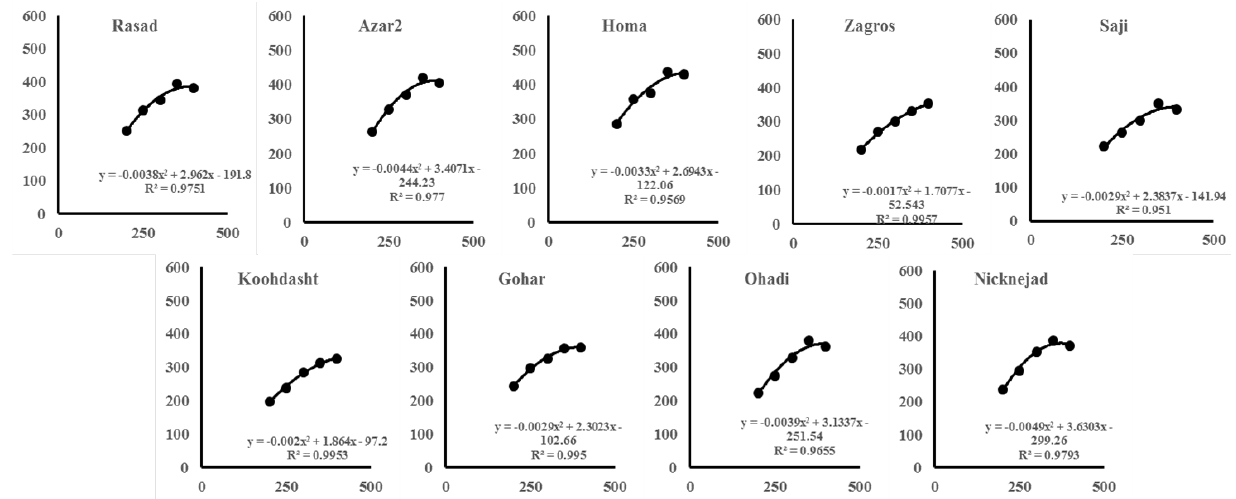
Fig. 4. Relations between the grain yield per unit area and plant density in wheat cultivars. X axis: Plant population (plant m -2 ); Y axis: Grain yield (g m -2